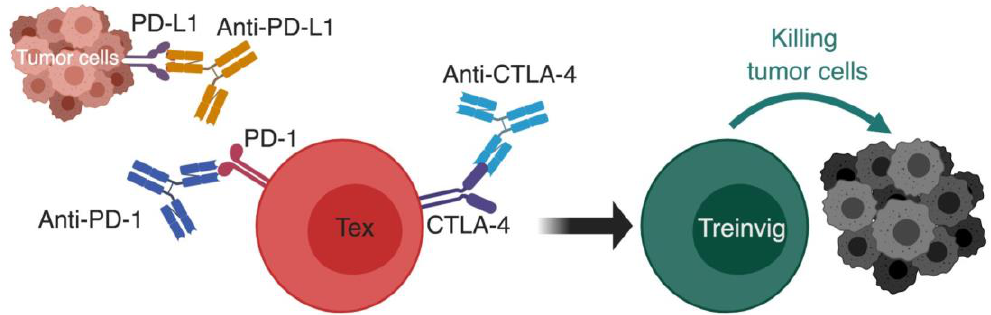
Figure 4. Using checkpoint blockade to reinvigorate exhausted T cells. The basic principal of immunotherapy by checkpoint blockade; monoclonal antibodies against inhibitory receptors such as PD-1:PD-L1 pathway and CTLA-4 are used to block the inhibitory signals on exhausted T cells, which causes their reinvigoration and restoration of effector functions that causes successful killing of tumor cells. CTLA-4, cytotoxic T lymphocyte antigen 4; PD-1, programmed cell death-1; PD-L1, programmed cell death ligand-1; Tex, exhausted T cell; Treinvig, reinvigorated T cells. *The different cells, receptors, ligands, and molecules are not drawn to scale. ** Created with